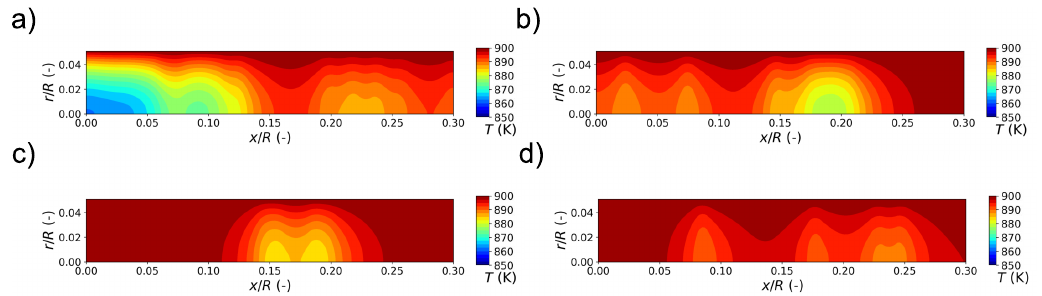
Figure 6. The temperature distribution for biogas composition (2): ( a ) initial, ( b ) 10th gen., ( c ) 20th gen., ( d ) 30th gen.